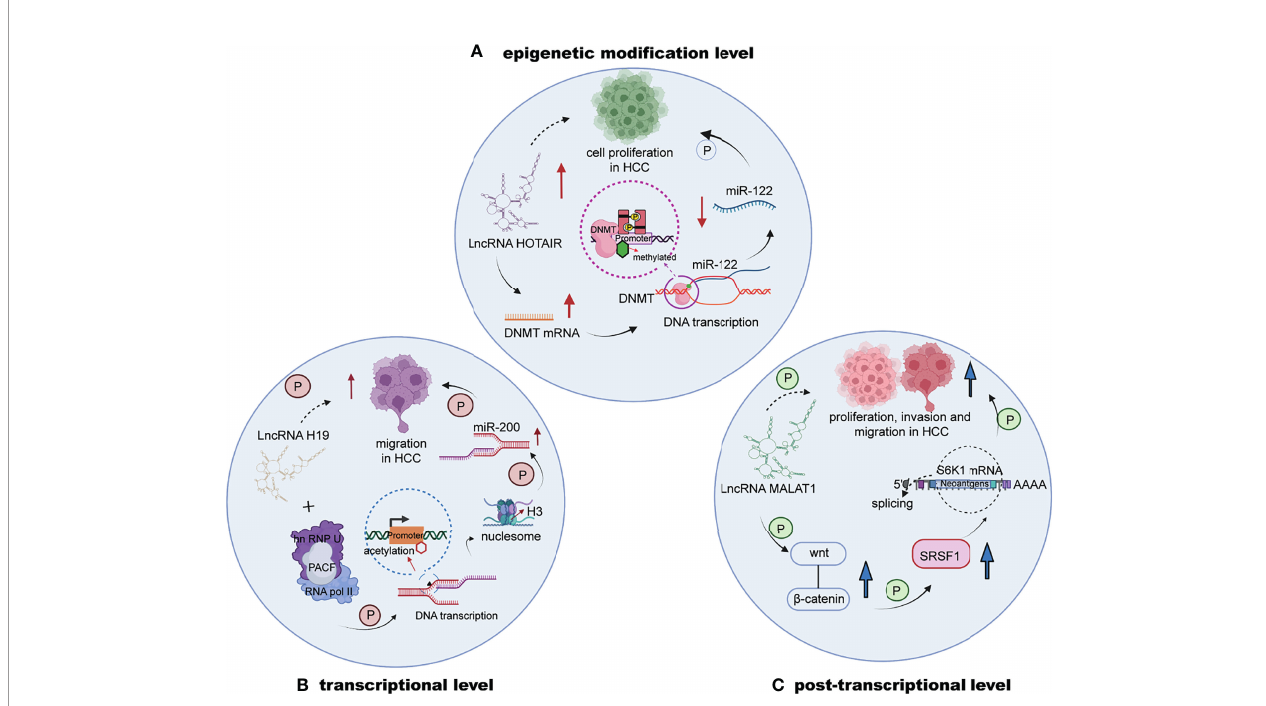
FIGURE 1 | The regulation of lncRNAs in HCC at the epigenetic, transcriptional or posttranscriptional level. (A) LncRNA HOTAIR upregulates DNMTs to increase the methylation of the promoter of miR-122, decreasing the expression of miR-122 to stimulate HCC cell proliferation. (B) The interaction of lncRNA H19 and the hnRNP U/PCAF/RNA pol II complex upregulates the transcriptional expression of the miR-200 family. (C) LncRNA MALAT1 is highly expressed and induces the progression of HCC by triggering the Wnt